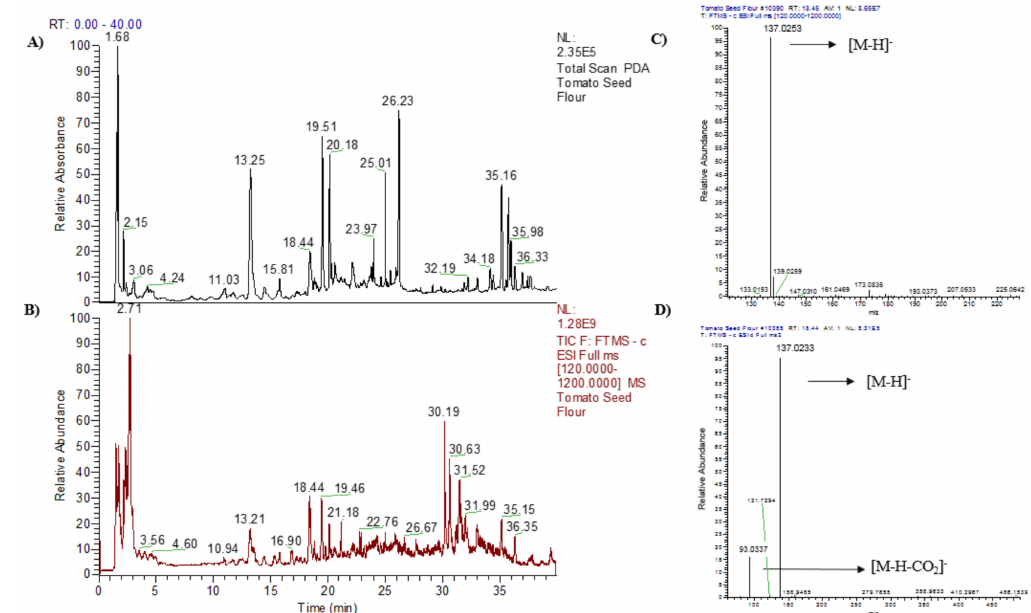
Figure 2. ( A ) Typical Ultra-High-Performance Liquid Chromatography-PDA (UHPLC-PDA) chromatogram and ( B ) total ion current (TIC) chromatogram of tomato seed flour extracts; ( C ) MS; and, ( D ) MS/MS spectra of peak 3 at the retention time of 18.44